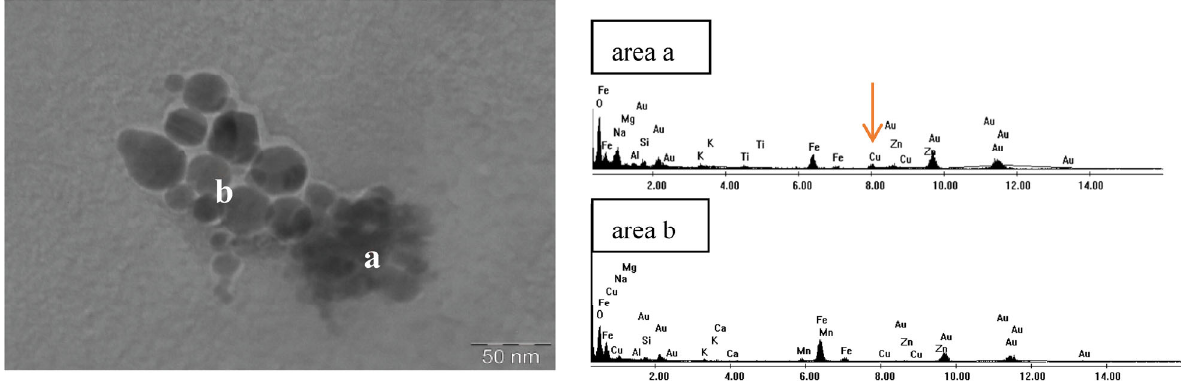
Fig. 10 TEM micrograph and relevant EDX spectra on iron containing debris collected by the stage 5 (average diameter of collected particles: 94 nm) of ELPI+, during dyno testing of the sample FM4-BD2. The Au characteristic lines are due to the gold grids used for TEM specimen